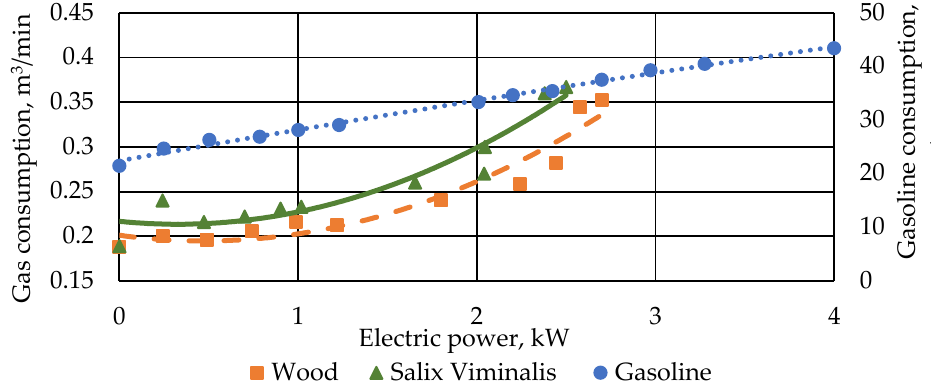
Figure 7. Power generator capacity.